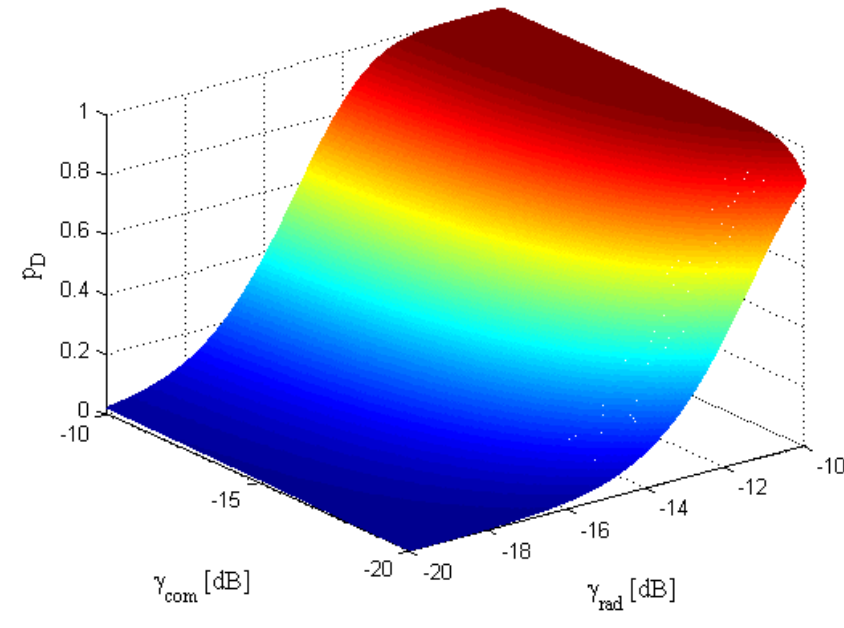
Figure 5. Variation in probability of detection p D with change in γ rad and γ com ( P rad = 500 W, δ FA = 10 − 6 , r th = 2 bpcu). Table 1. Comparisons of probability of detection and communication rate employing